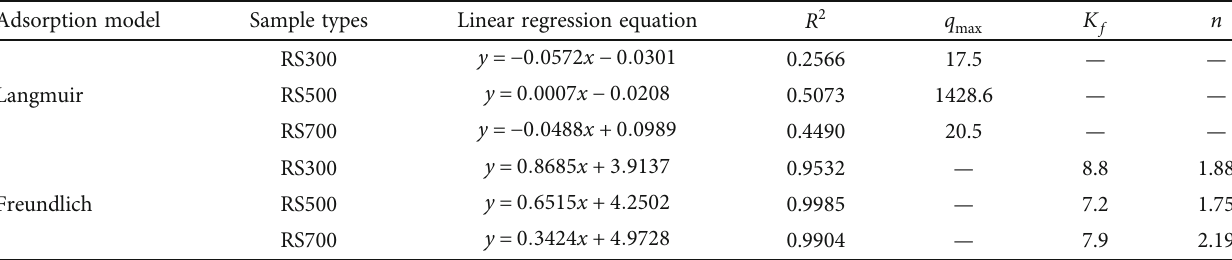
Table 3: Competitive adsorption model of Cd 2+ in acidic solution of straw